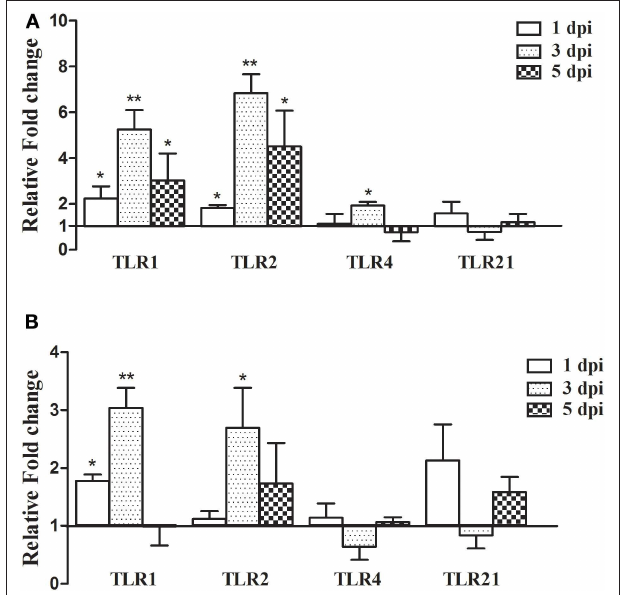
FIGURE 4 | TLR gene expression in the lungs and spleen after infection with Aspergillus fumigatus . Spleen and right lungs were sampled at 1, 3, and 5 dpi. Gene expressions in infected chickens were expressed as fold change compared to the control group [means ± SD ( n = 3)]. β -actin and GAPDH were used as reference genes. (A,B) were the expression of TLR gene in the lungs and spleen, respectively. The Y-axis indicates that the relative fold changes of the target gene expression in the Aspergillus fumigatus group vs. those in the control group. * p < 0.05, ** p <